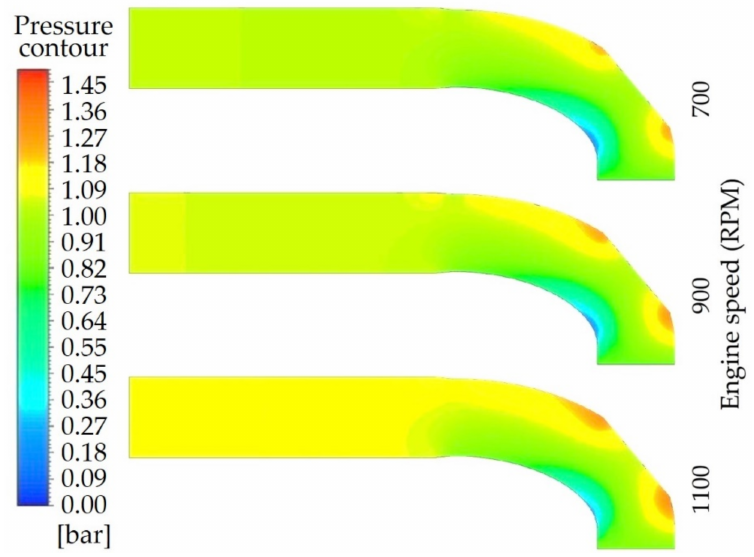
Figure 10. Contours of pressure results of the 3D zone in the intake